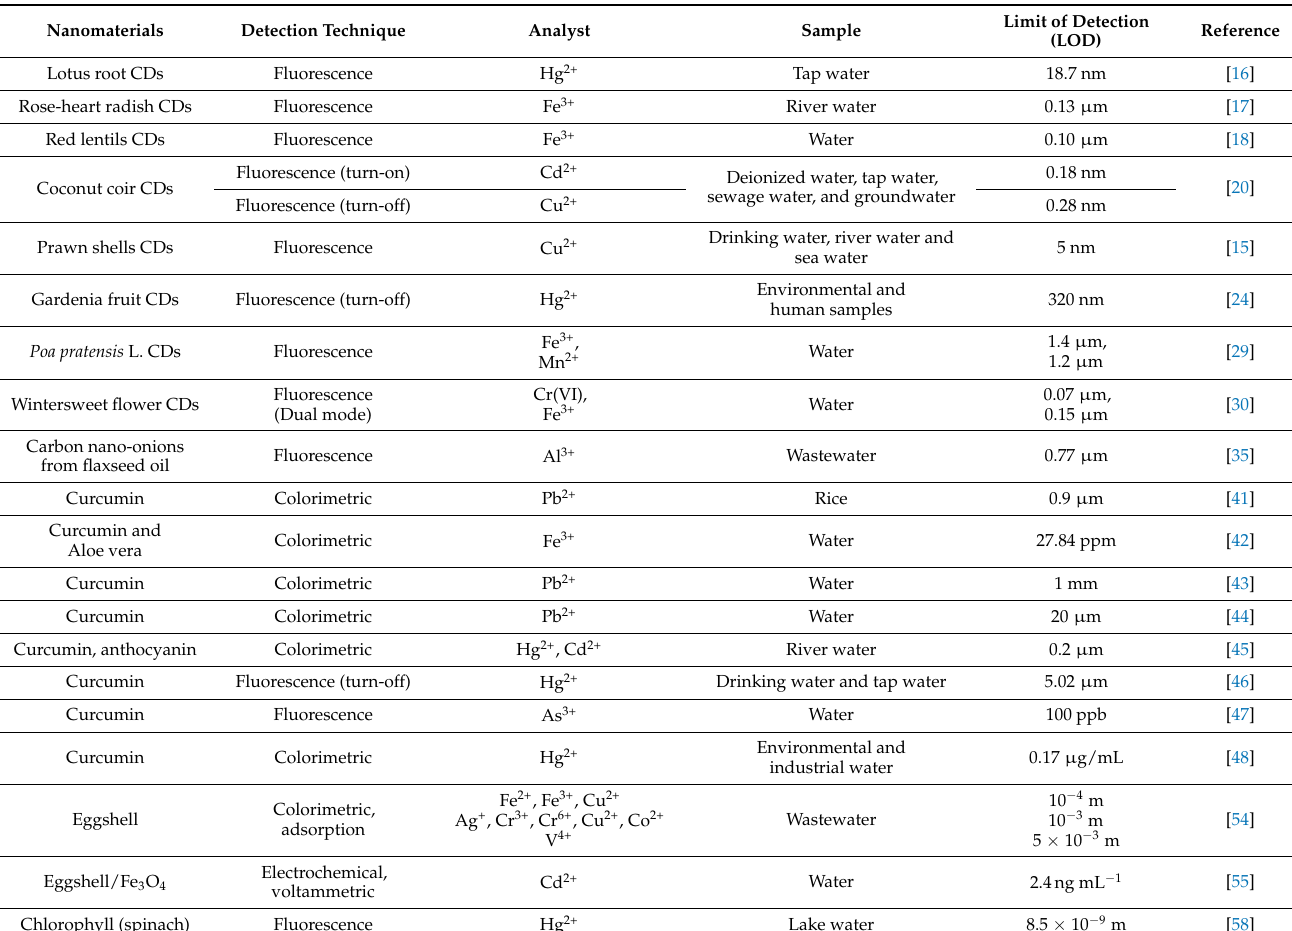
Table 1. Natural nanotechnology-based sensor for detection of heavy metal